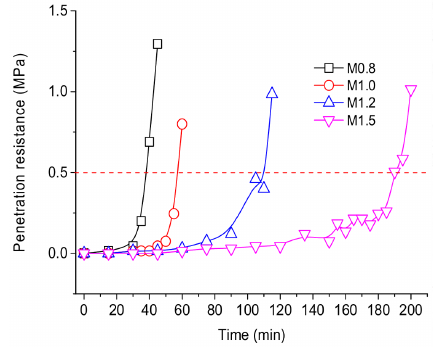
Figure 6. Effect of SiO 2 /Na 2 O ratio on penetration resistance of the geopolymer coating.